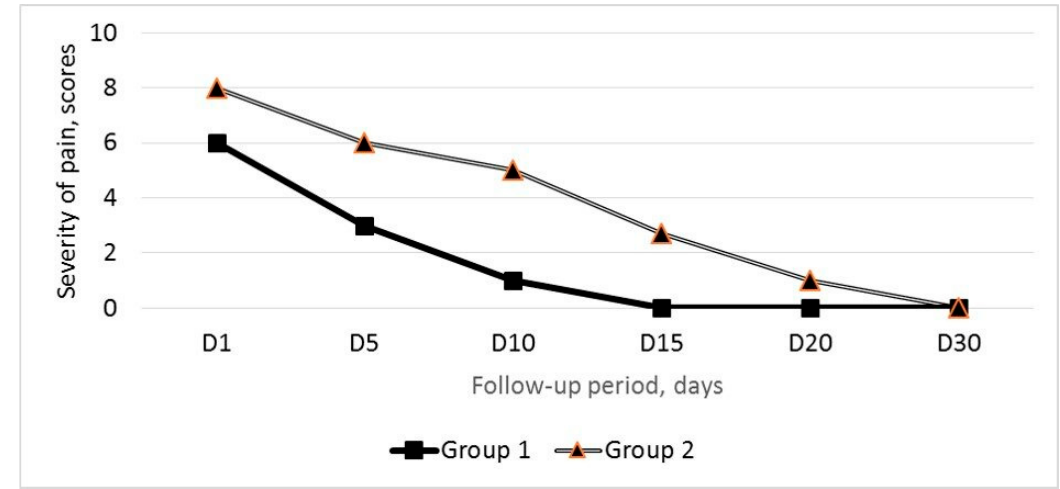
Figure 5. Changes in the mean post-embolization pain score measured by VAS after the endovascular embolization of gonadal veins in the groups 1( n = 38) and 2 ( n = 32).